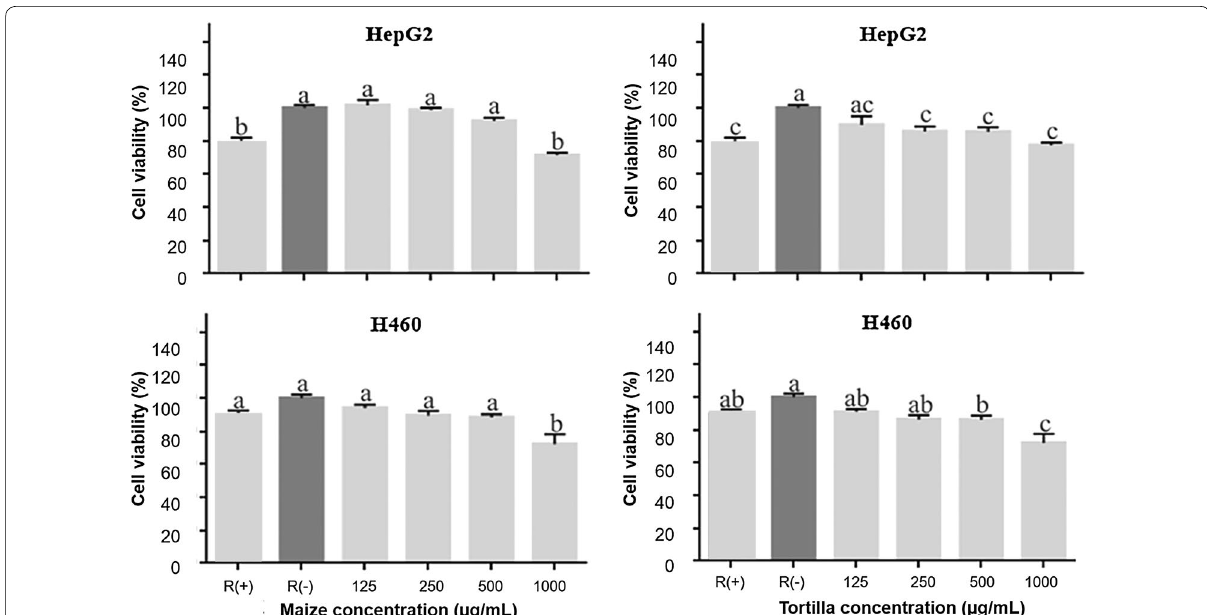
Fig. 2 Effect of blue corn and tortilla extracts on cell viability in HepG2 and H460 human cancer cell lines. R ( medium. Different letters indicate that there are significant differences (p